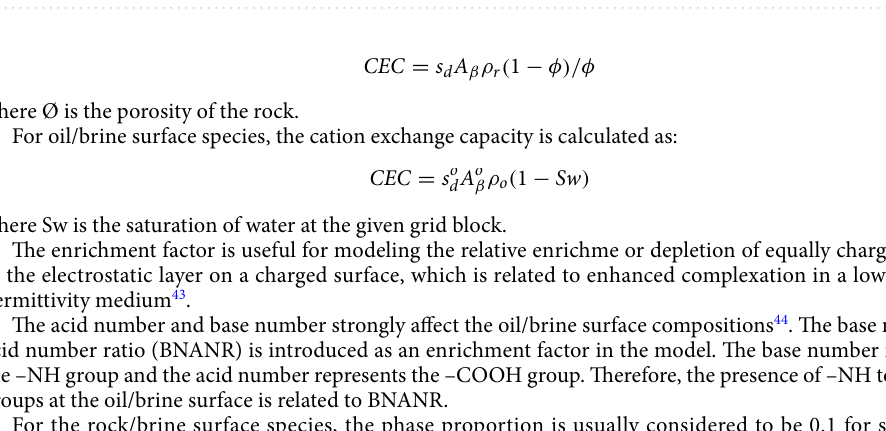
Figure 1. Summary of calculation functions used in the developed